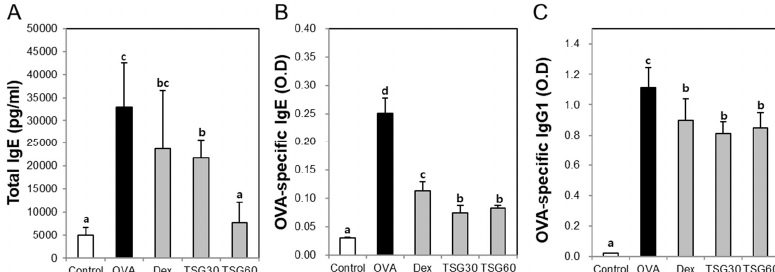
Figure 5. The effects of TSG on Th1 and Th2-mediated immunoglobulins (IgG’s) in serum. ( A ) total IgE, ( B ) OVA-specific IgE, and ( C ) OVA-specific IgG1 were measured by ELISA. Group data are as means ± SD for five mice per group. a, b, c, and d: The means not sharing a common letter are significantly different between groups at p < 0.05 as measured by one-way ANOVA with Duncan’s multiple-range